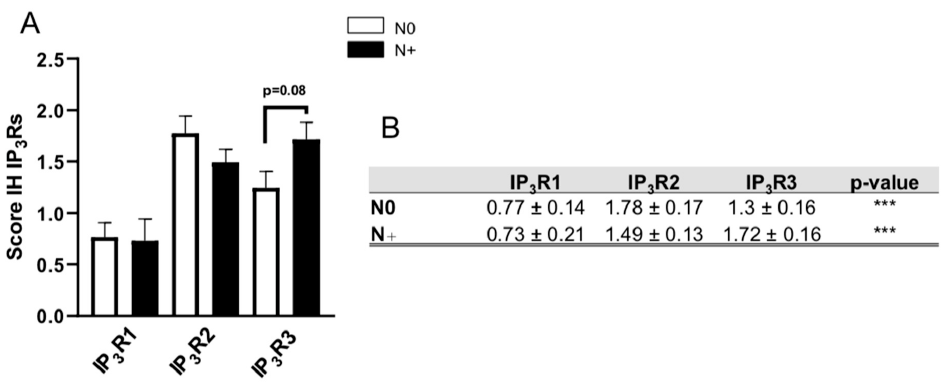
Figure 3. The IP 3 R IH expression scores as a function of lymph node status ( A , B ). *** p < 0.001.